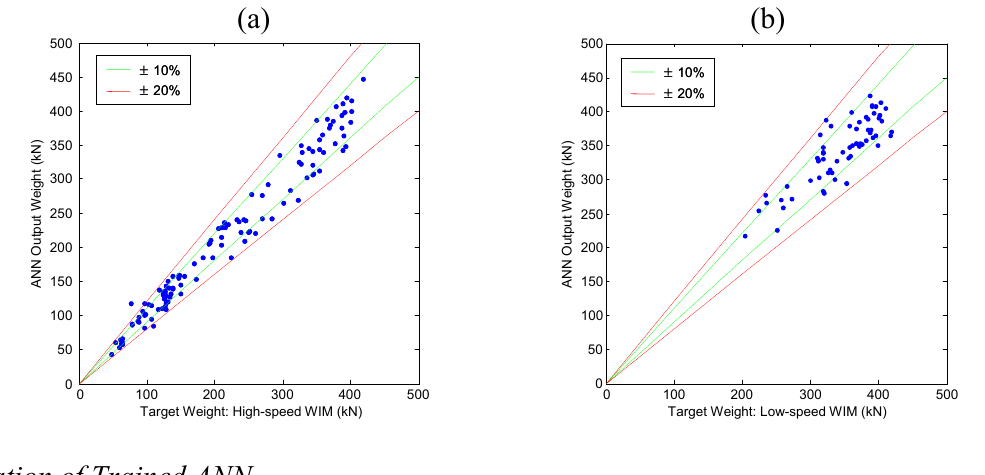
Figure 8. Results of training of (a) Geumdang Bridge — cross beam strain. (b) Seohae Bridge — north bound 3 rd